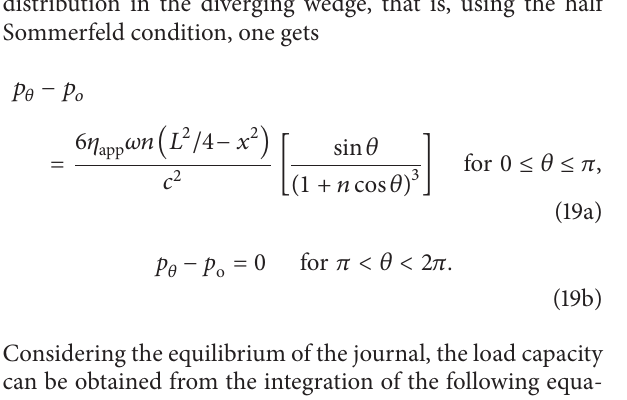
Figure 1: Squeeze film dampers with orbital